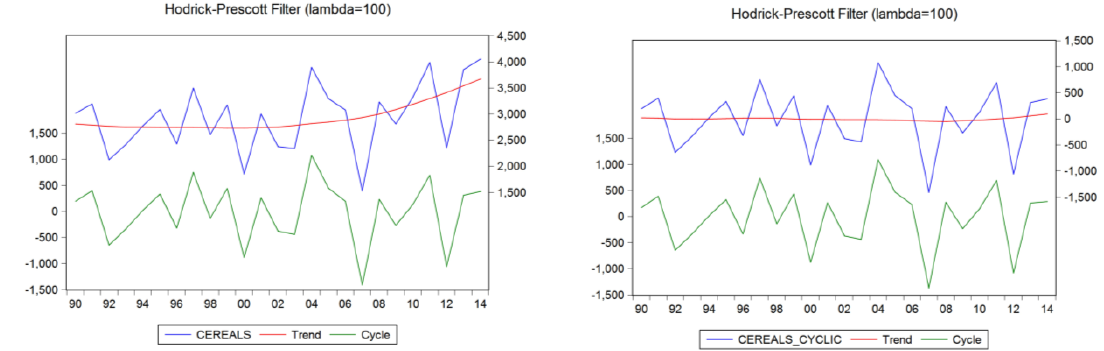
Figure 5. Variation of yield for cereals in Romania. Source: authors own computation based on [56].